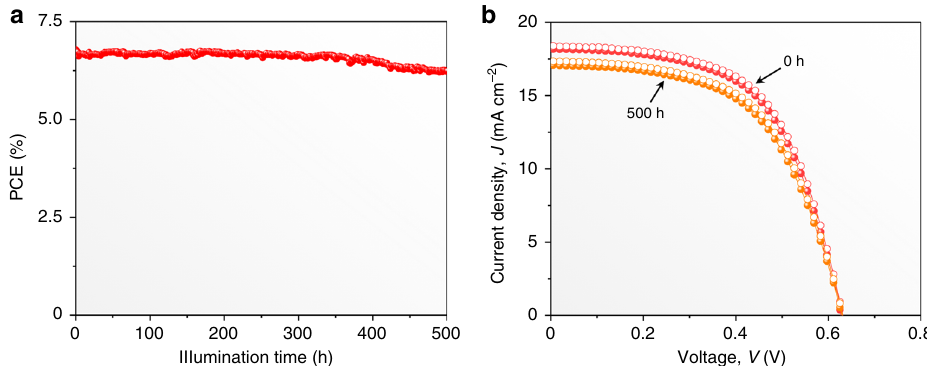
Fig. 5 Device stability of CsSn 0.5 Ge 0.5 I 3 thin- fi lm PSCs. a PCE evolution of a typical unencapsulated PSC in continuous operation under 1-sun illumination at 45 °C in N 2 atmosphere. b Initial J – V curves (reverse and forward scans) of the PSC and ones at the 500-h mark during continuous